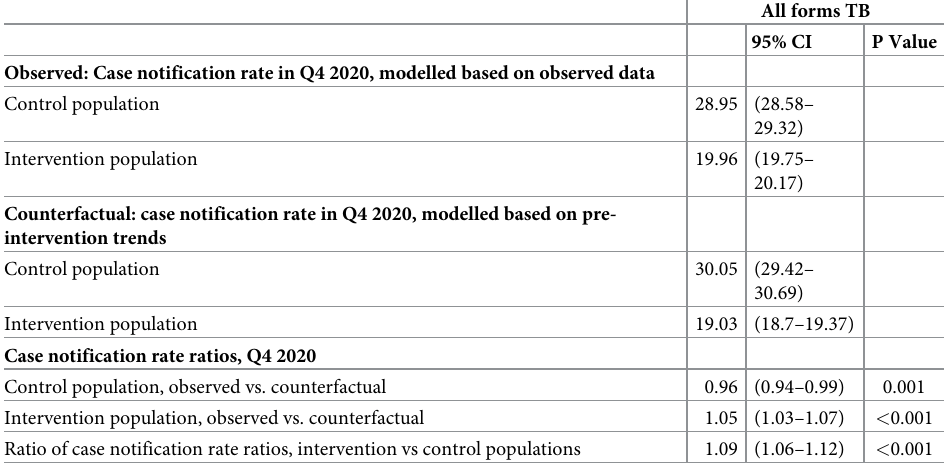
Table 4. Modeled TB case notification rates for the control and intervention populations at the end of the 2-year intervention (Q4 2020) as compared to the counterfactual, and the case notification rate ratios for the interven- tion vs control populations, for all-forms